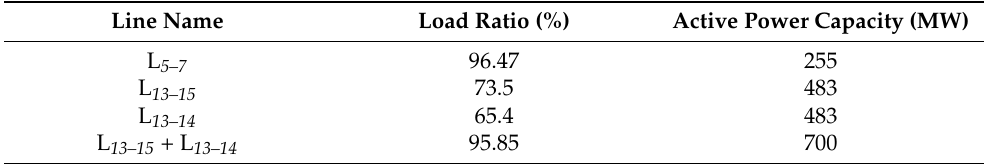
Table 3. Initial load ratio of critical lines (without multi-terminal DC (MTDC).